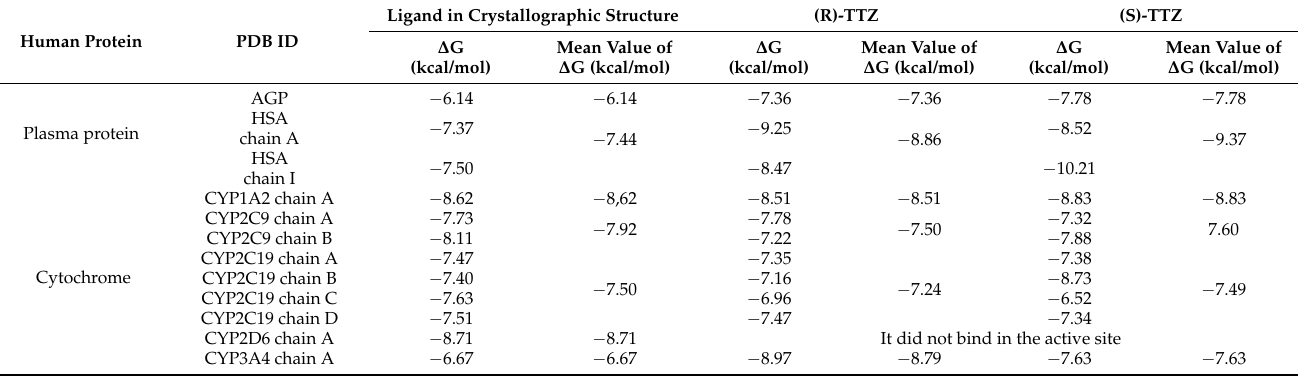
Table 7. Interaction energies ( ∆ G) between the stereoisomers of triticonazole (TTZ) and human plasma proteins and cytochromes, respectively. This table also contains the interaction energies obtained for the docking of the ligands that were present in the crystallographic structures of the investigated